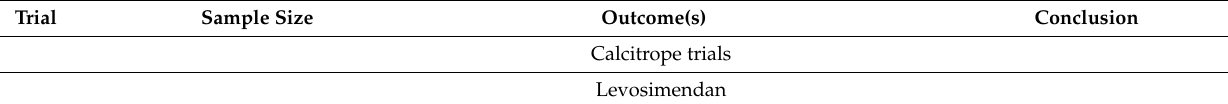
Table 2. Summary of studies investigated novel calcitrope and myotrope